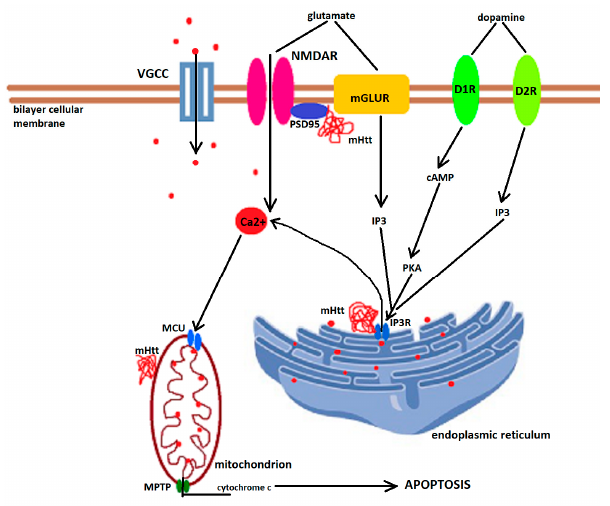
Figure 2. Impaired calcium homeostasis in Huntington’s disease leading to apoptosis. Mutant huntingtin (mHtt) enhances NMDA receptor (NMDAR) function, possibly through decreased interaction with the PDS95 (postsynaptic density 95)/NMDAR complex. Dopamine released by the dopaminergic neurons acts on D1 receptors (D1R), which activate adenyl cyclase, the increased cAMP levels activating phosphokinase A (PKA), which, in turn, stimulates the inositol 1,4,5-phosphate receptors (IP3R), while dopamine acting on D2 receptors directly activate IP3R. IP3R activation leads to release of Ca 2+ from the endoplasmic reticulum. Excessive cytosolic calcium is taken up by mitochondria through the mitochondrial calcium uniporter (MCU), but will lead to opening of the mitochondrial permeability transition pore (MPTP), especially when mHtt directly associates with mitochondrial membrane proteins. VGCC—L-type voltage-gated calcium channel; red dots—calcium; red whirl—aberrantly folded mutant huntingtin